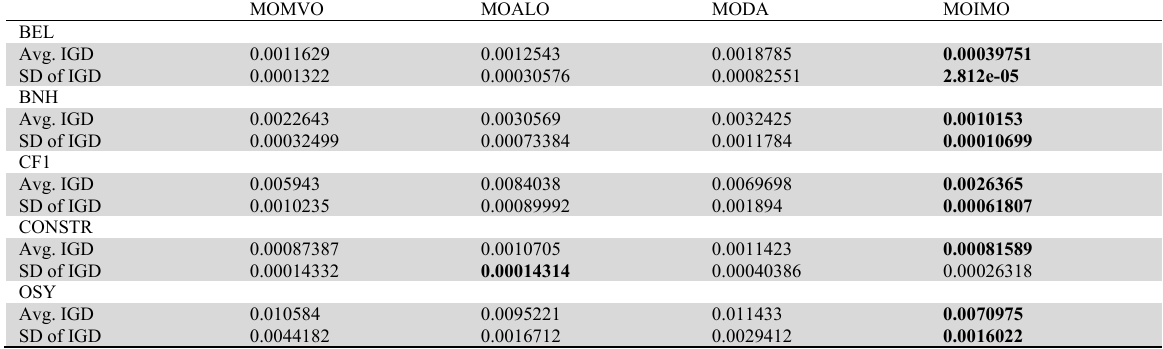
Results of the multiobjective algorithm (using spread) on the constrained test functions MOMVO MOALO